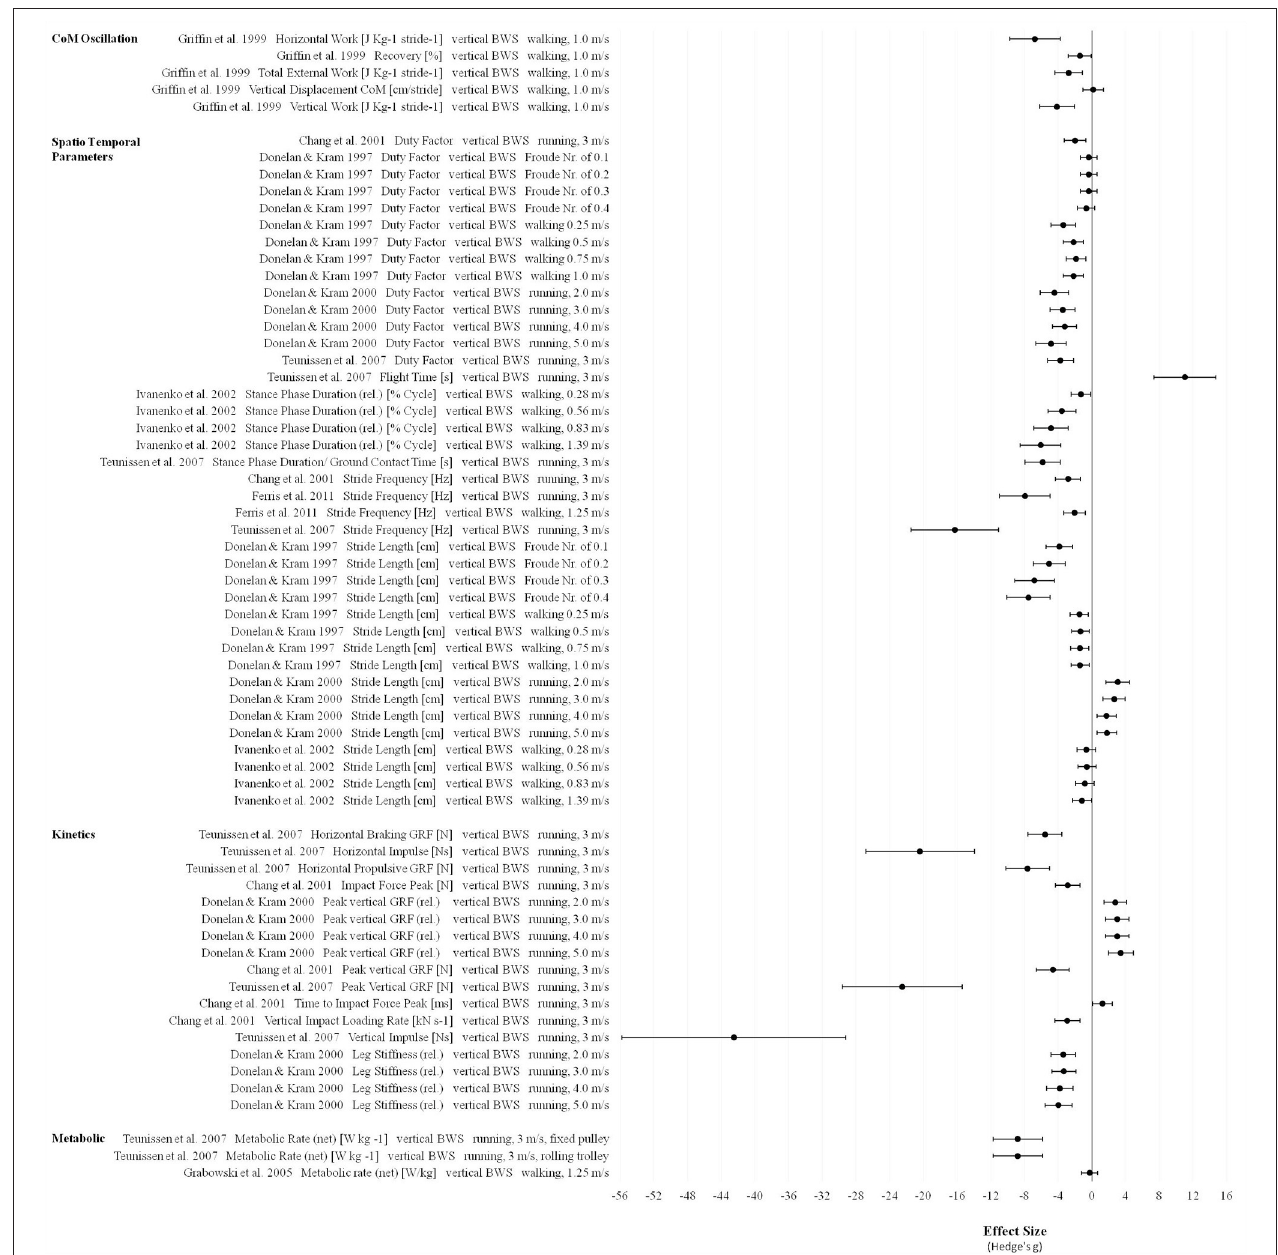
FIGURE 8 | Effect sizes (Hedge’s g) and confidence intervals for biomechanical and cardiopulmonary parameters in 0.25g compared to